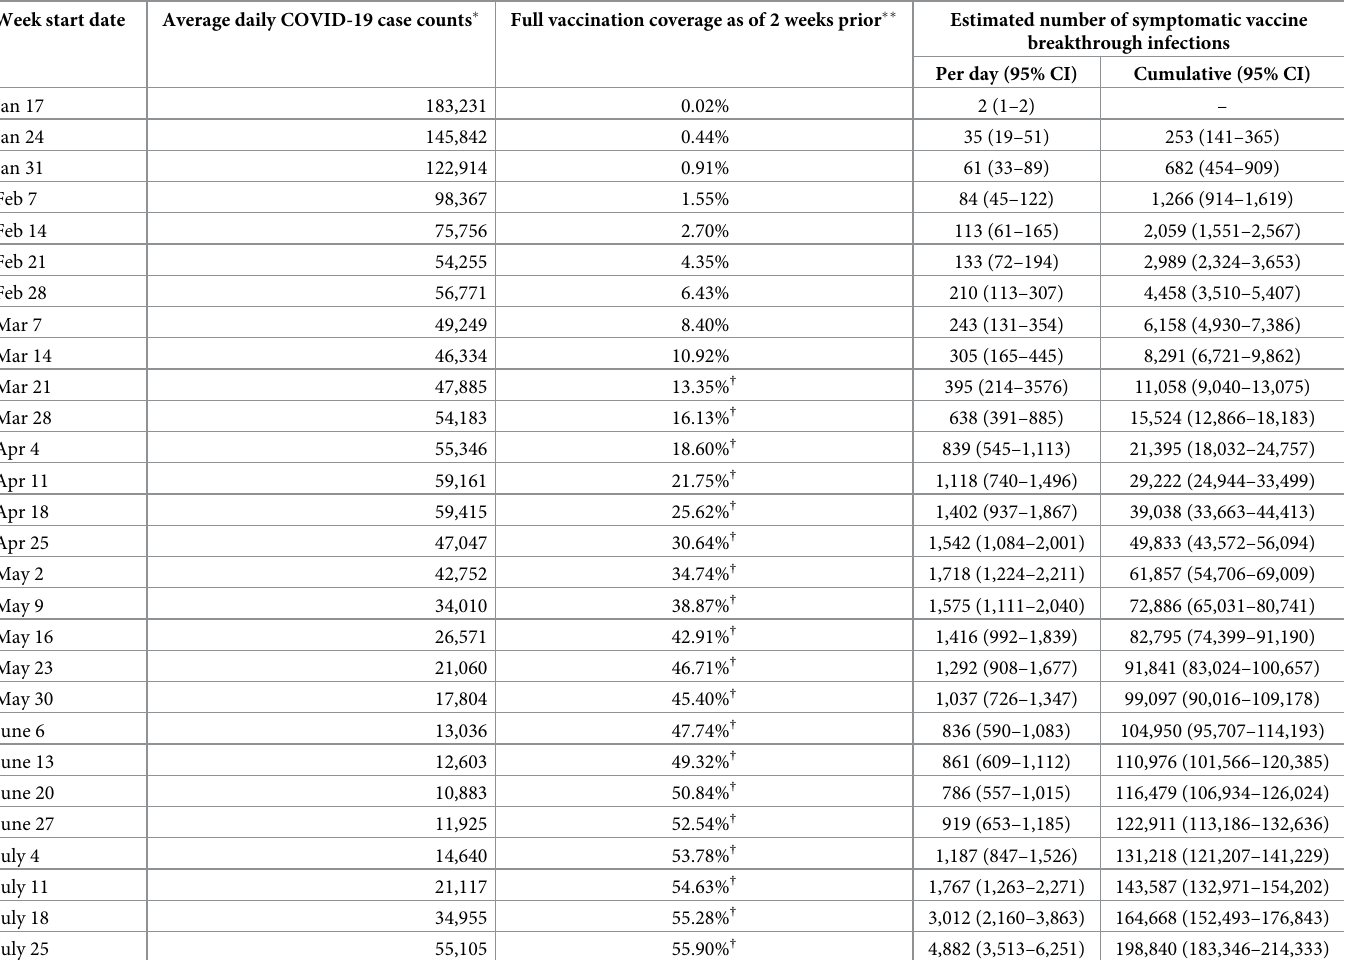
Table 1. COVID-19 case counts, vaccine coverage, and estimated number of expected symptomatic vaccine breakthrough infections, by week—United States, Janu- ary–July